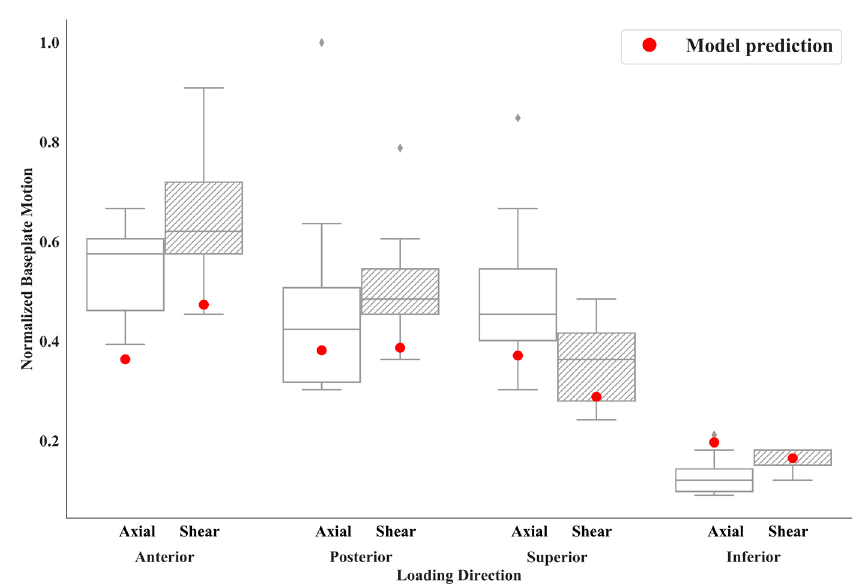
Figure 4. Baseplate displacement measured experimentally (boxplot) and determined from the model (red dots). For the FE analysis, predicted values were calculated as the average of the displacements for the nodes lying in the measurement patch, as defined in Section 2.2.3. Data were normalized to the largest micromotion measured in any of the tests. For each of the four main implant directions, both axial and shear displacements were measured. Gray points represent outliers in the measurements.